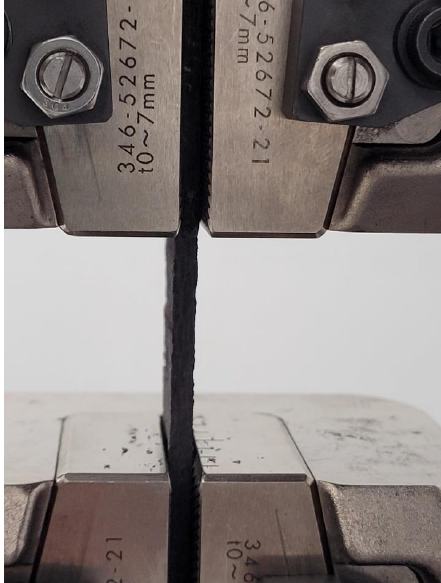
Figure 4. Compression test setup.